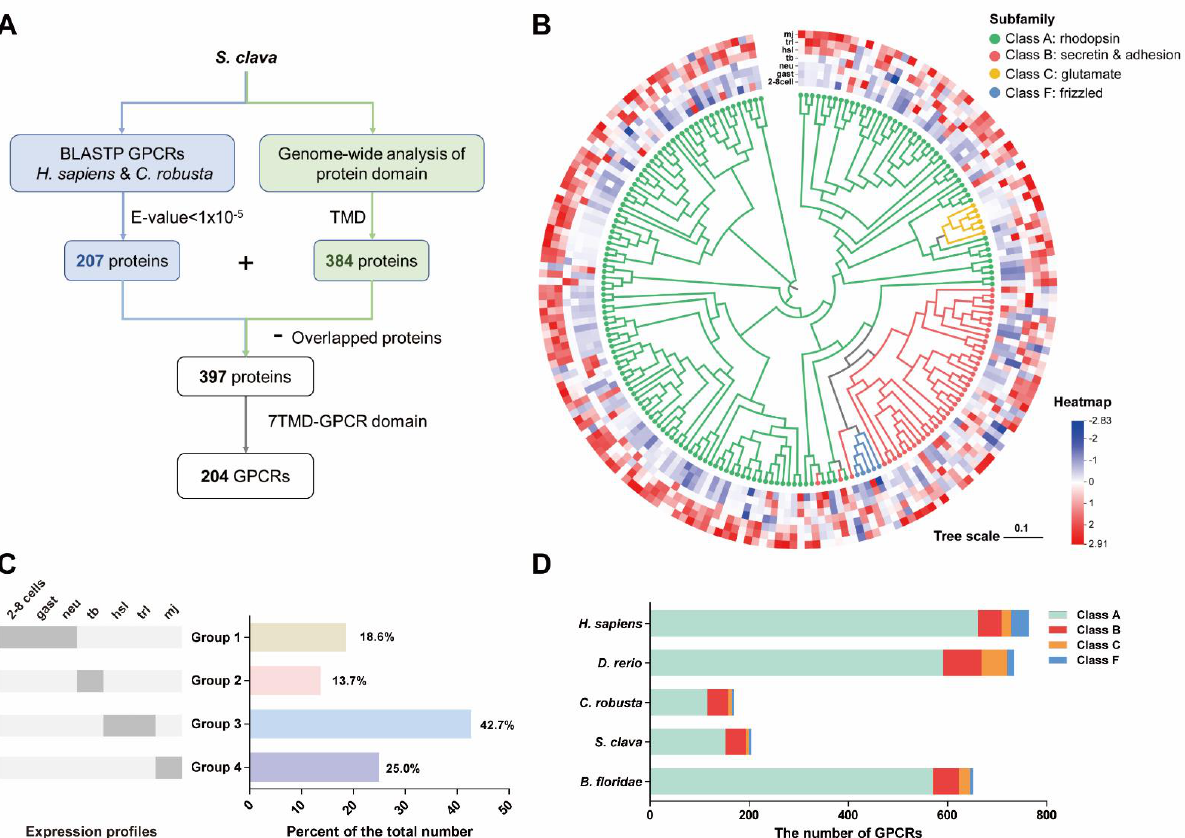
Figure 1. Identification of the GPCR superfamily from S. clava . ( A ) The strategy employed in searching putative S. clava GPCR protein sequences. ( B ) Phylogenetic tree of the putative S. clava GPCR was constructed using the Neighbor-Joining method. The receptors from different subfamilies (Classes) are clustered with different colors. The Gene ID and NCBI accession numbers for sequences used in the phylogenetic analysis can be found in Table S1. Expression profiles of GPCR genes across different developmental stages are shown on the corresponding branch side. The expression level of each gene is represented by a square with a color-coding for the values of lg (FPKM + 1). The color scale represents fold changes: red indicates high expression and blue represents low expression. The developmental stages included: 2-cell – 8-cell embryos (2 – 8 cells), gastrula embryos (gast), neurula embryos (neu), tailbud-stage embryos (tb), hatched swimming larvae (hsl), tail-regression larvae (trl), and metamorphic juveniles (mj). ( C ) Classification of putative S. clava GPCRs according to the expression profiles across different developmental stages. ( D ) Distribution of the number of GPCR subfamilies in several chordate species.